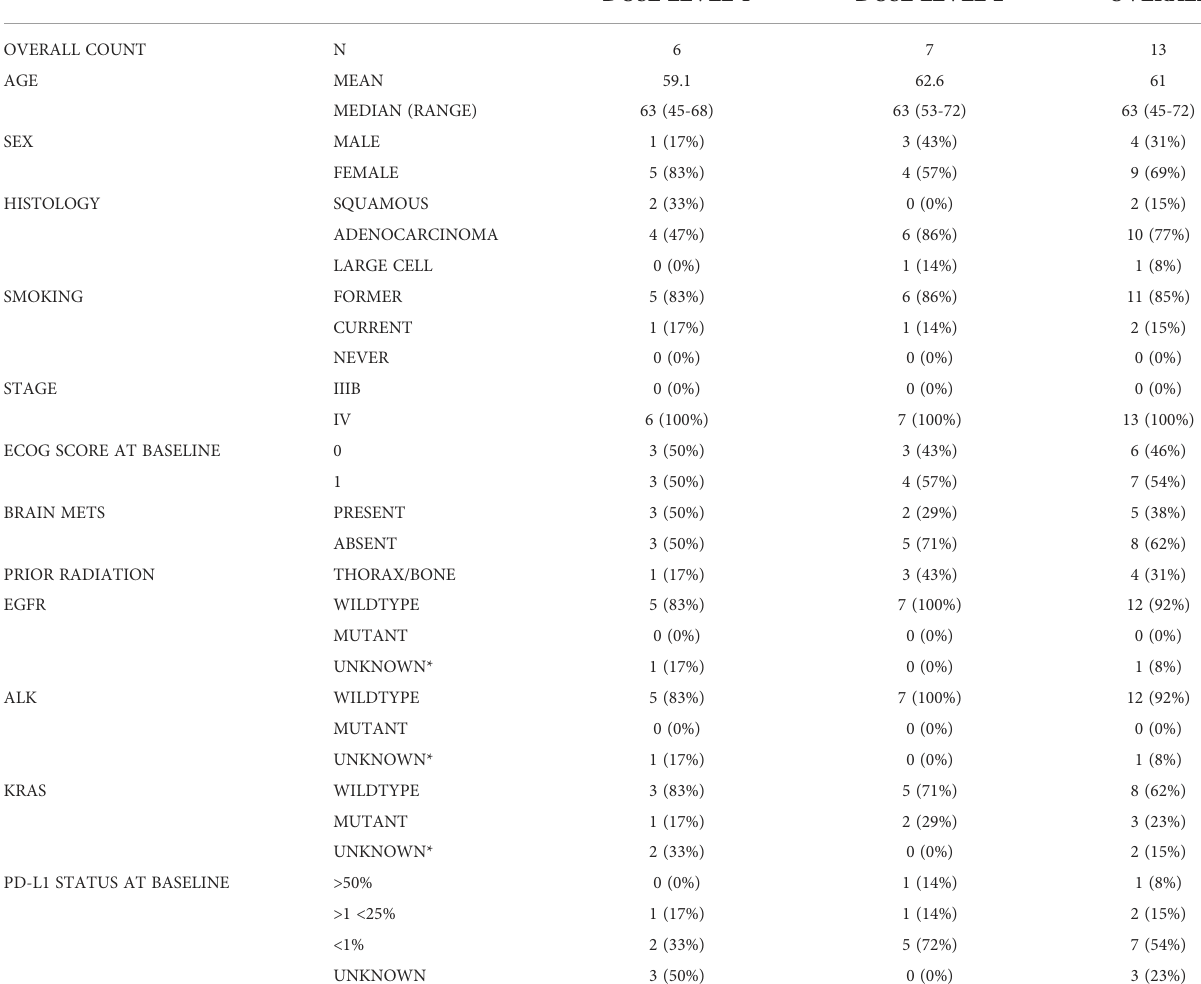
TABLE 1 Descriptive baseline statistics by dose